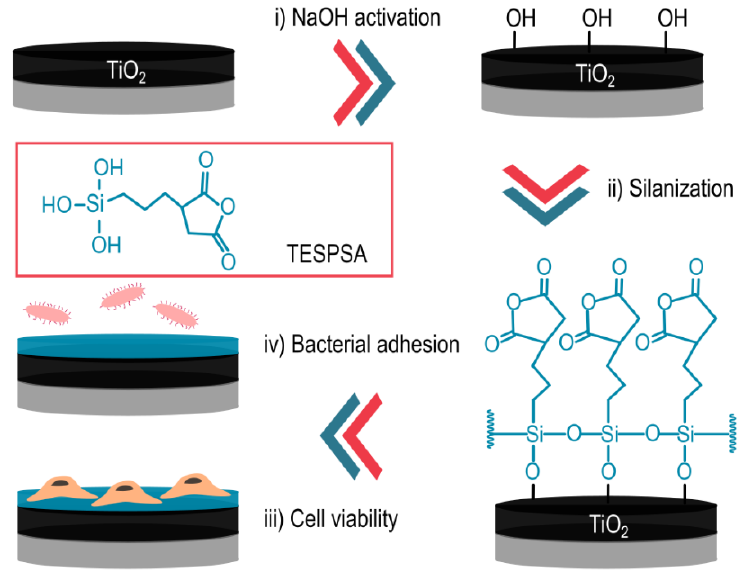
Figure 1. Functionalization strategy of triethoxysilylpropyl succinic anhydride (TESPSA). ( i ) Titanium surface (TiO 2 ) is activated by NaOH treatment. ( ii ) Next, the activated surface is coated with TESPSA molecules by silanization process. ( iii ) Treated surfaces did not reveal toxic effects onto fibroblast cells. ( iv ) Following cell viability assay, TESPSA surfaces are able to reduce bacterial adhesion.